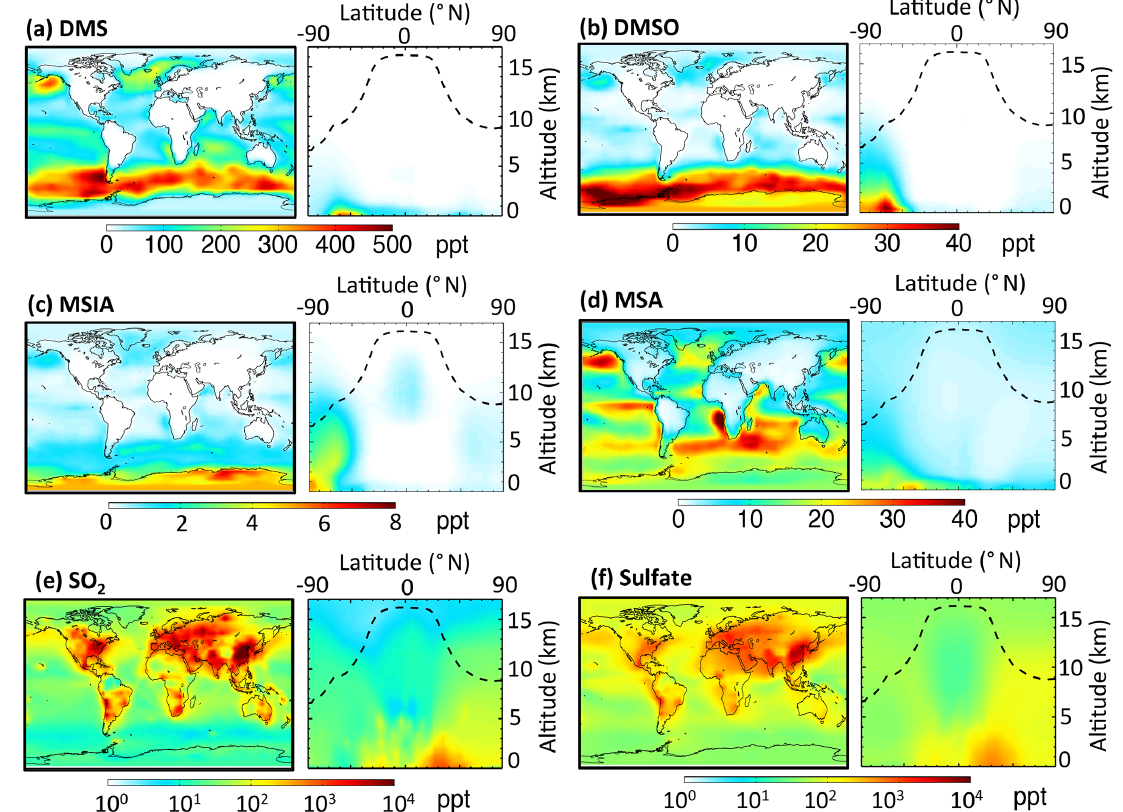
Figure 2. Horizontal distribution of annual-mean surface mixing ratios (ppt) and vertical distribution of mixing ratios for (a) DMS, (b) DMSO, (c) MSIA, (d) MSA, (e) SO 2 and (f) sulfate. The dashed line indicates the climatological tropopause